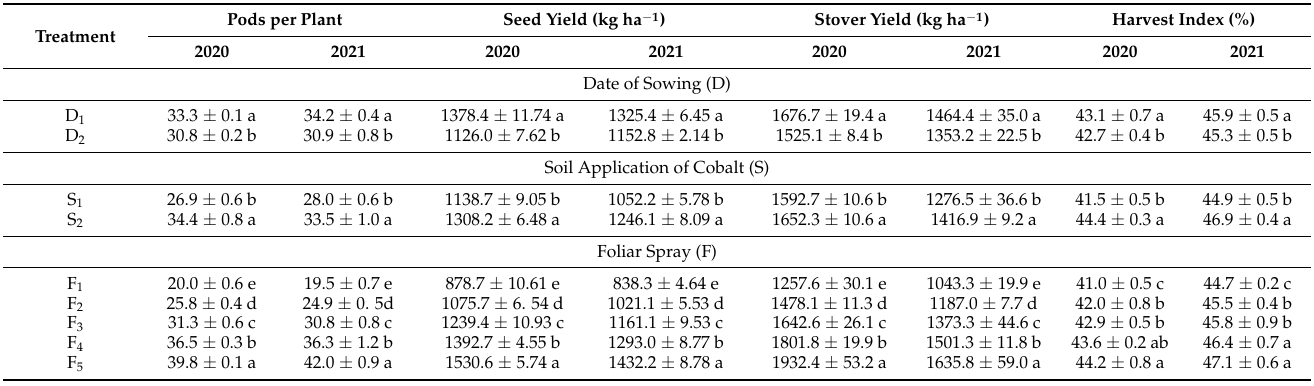
seed and stover yield of blackgram (Table 12). Accordingly, the harvest index of black gram also differed with the sowing dates and nutrient application. Separately, the March first week sowing, Co application, and foliar K+B registered 43.1%, 44.4%, and 44.2% in 2020 and 45.9%, 46.9%, and 47.1% harvest index in 2021, respectively, which were statistically significant over their corresponding treatments to be compared (Tables 11 and 12). How- ever, only the date of sowing and Co application interacted significantly among themselves with respect to harvest index in the respective years. Table 11. Yield characteristics of black gram under different dates of sowing and different nutrient. Pods per Plant Seed Yield (kg ha − 1 ) Stover Yield (kg ha − 1 ) Treatment